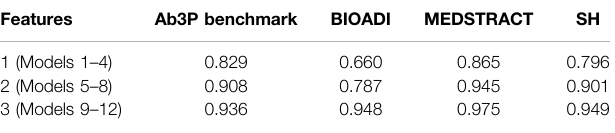
TABLE 10 | Models with more features are more con fi dent when they are correct. Models 1 – 4 use a single feature ( rank ). Models 5-8 add charmatch .